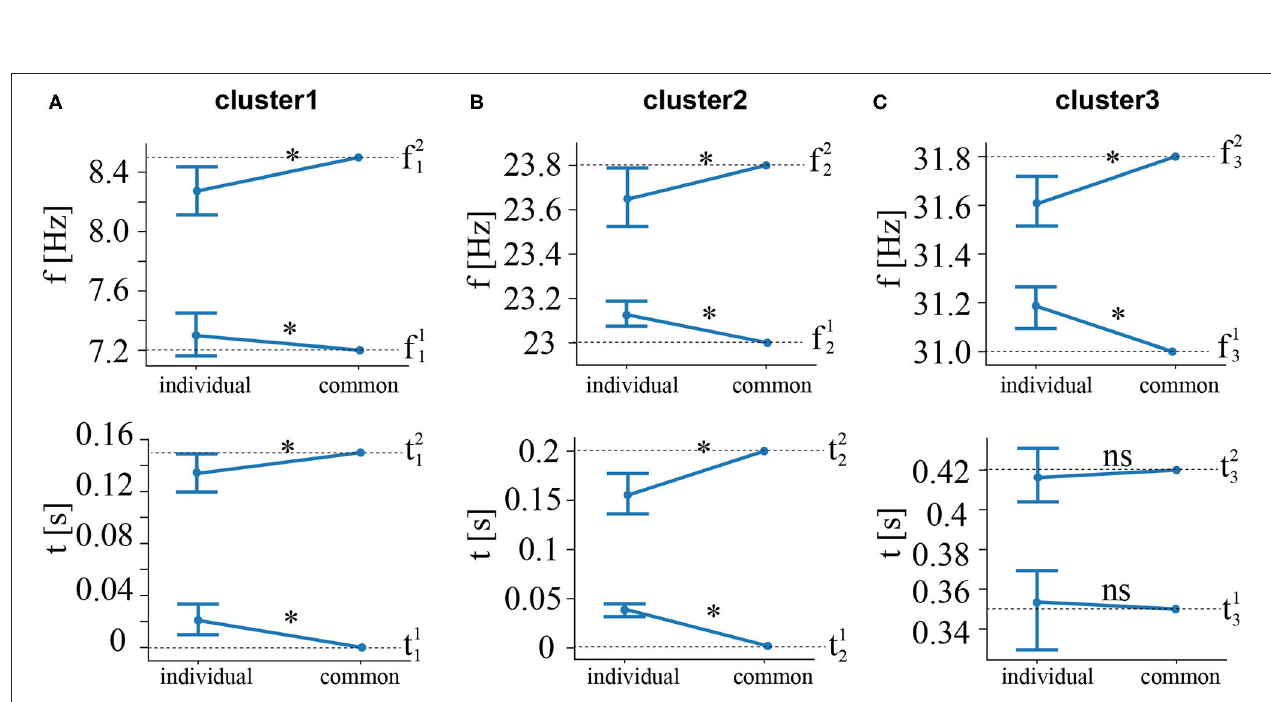
FIGURE 5 | Changes in the frequency (upper row) and time (bottom row) ranges when one subject is excluded from the feature selection procedure. The (A–C) correspond to different clusters. Frequencies ( f i 1,2 ) common and times ( t i 1,2 ) common are obtained when including all 20 subjects. The values ( f i 1,2 ) individual and ( t i 1,2 ) individual reflect the time-frequency bands obtained when one subject is excluded. ( t i 1,2 ) individual are shown as group mean and 95 % confidence interval. ∗ p < 0.05, via a repeated measures ANOVA and a post-hoc t